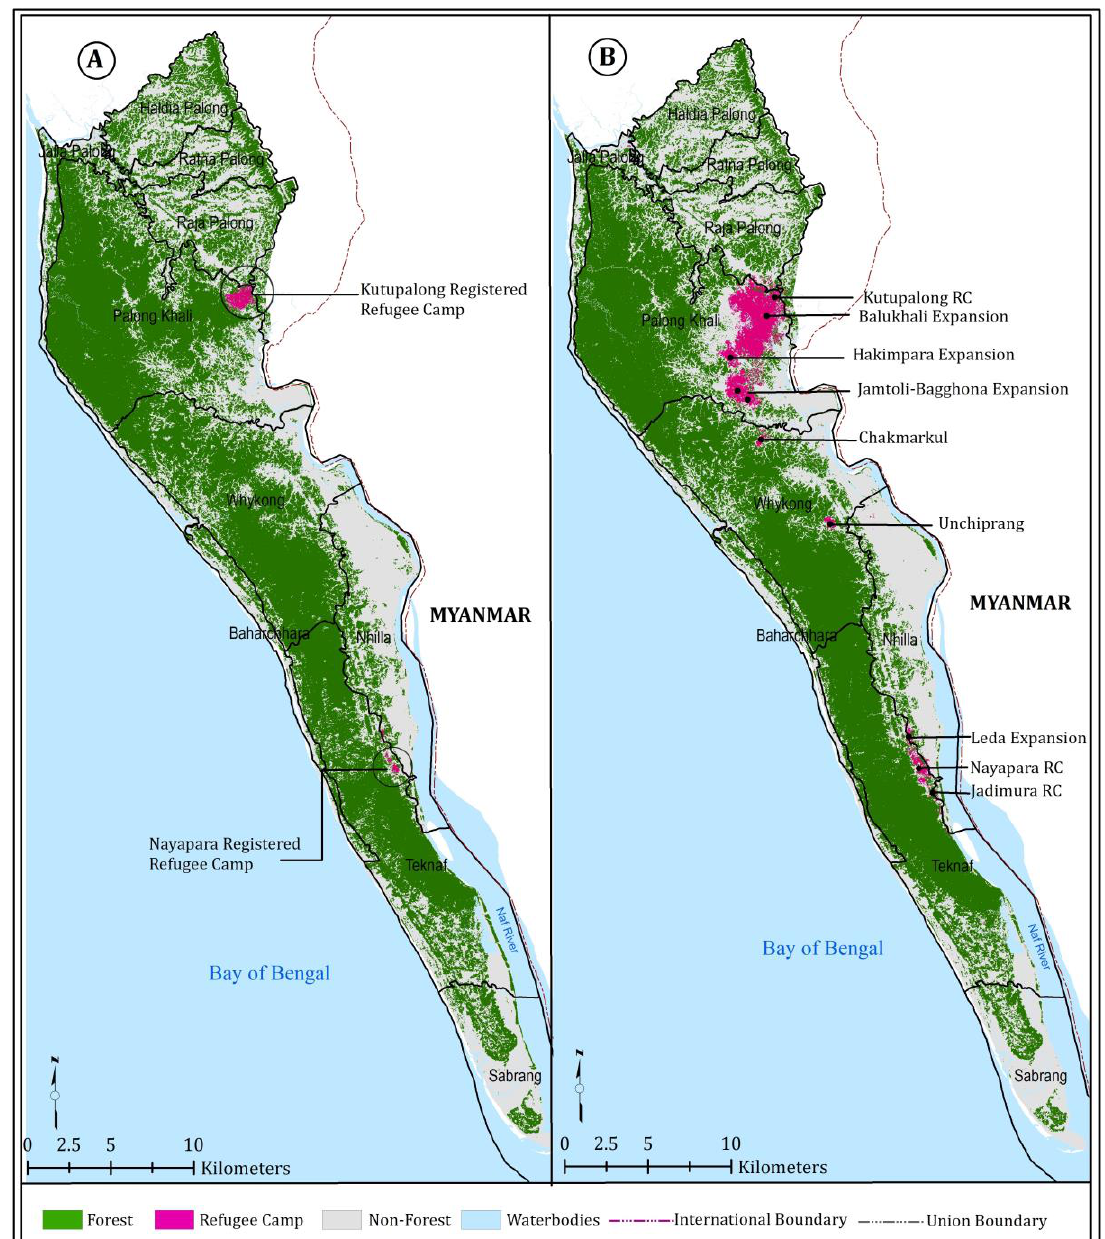
Figure 5. Land cover maps for the study area classified into three major land cover classes, including forest (green), refugee camp (fuchsia), and nonforest (gray), at two time-steps representing pre-influx: ( A ) December 2016 and post-influx: ( B ) December 2017. The pre-influx map ( A ) shows two refugee settlement camps; however, in the post-influx land cover map ( B ), many additional, spontaneous camps are visible with forested land replaced by continuous expansion of refugee settlements.